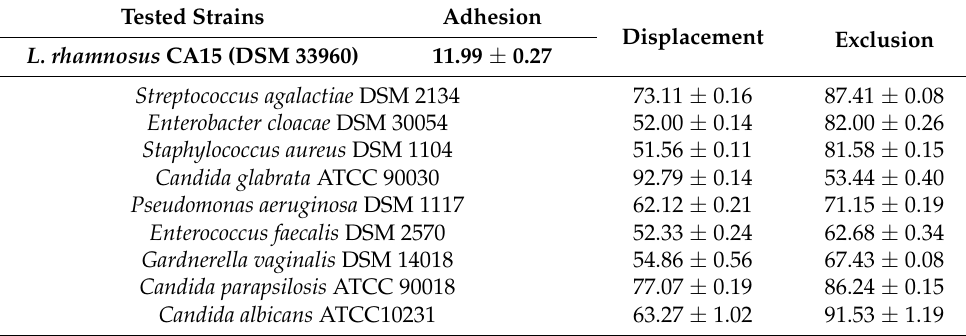
Table 5. Adhesion of the L. rhamnosus CA15 (DSM 33960) strain to intestinal mucus and effect on adhesion ability of pathogens.